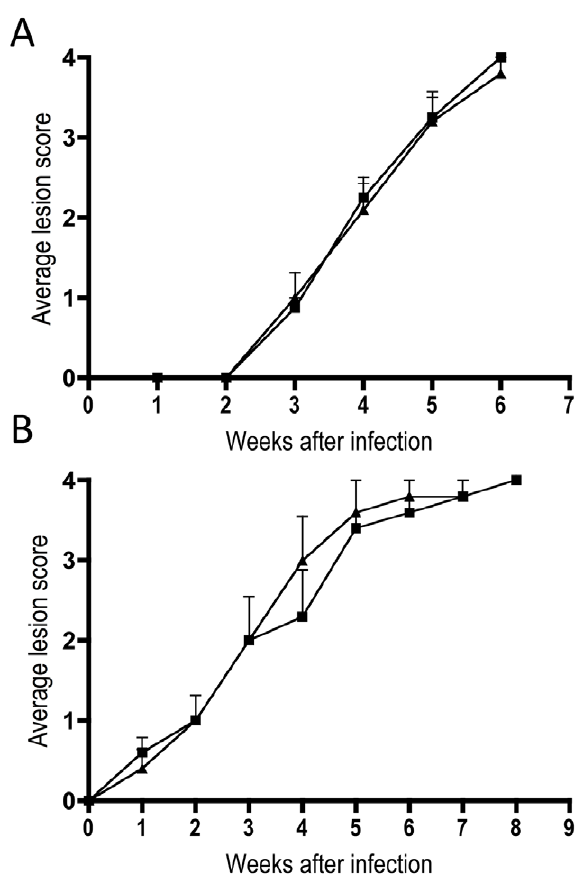
Figure 6. Subcutaneous infection of susceptible BALB/c mice with either promastigote (A) or amastigote (B) forms of L. major . Mice were infected with either wild type (squares) or D msrA (triangles) parasites and lesion scores monitored weekly. Error bars represent S.E.M. ( n= 5).